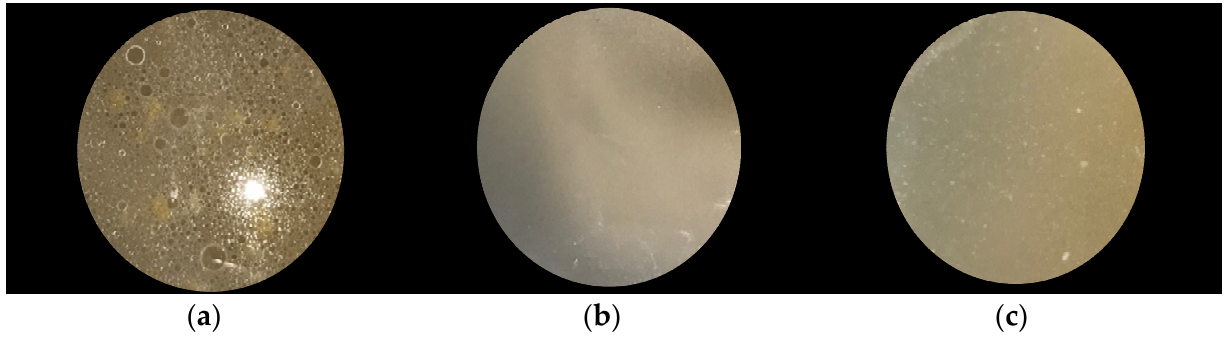
Figure 5. EVOO release from nugget samples prepared with: ( a ) deep-fat precooking, ( b ) oil-free precooking, and ( c ) new technology, followed by final cooking step.